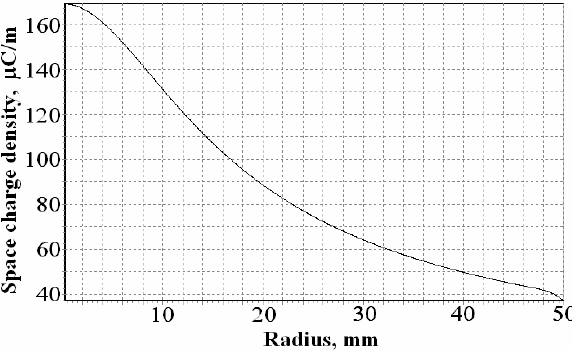
Fig 1. Computed ion space charge density distribution along the radius in the combined corona-electrostatic